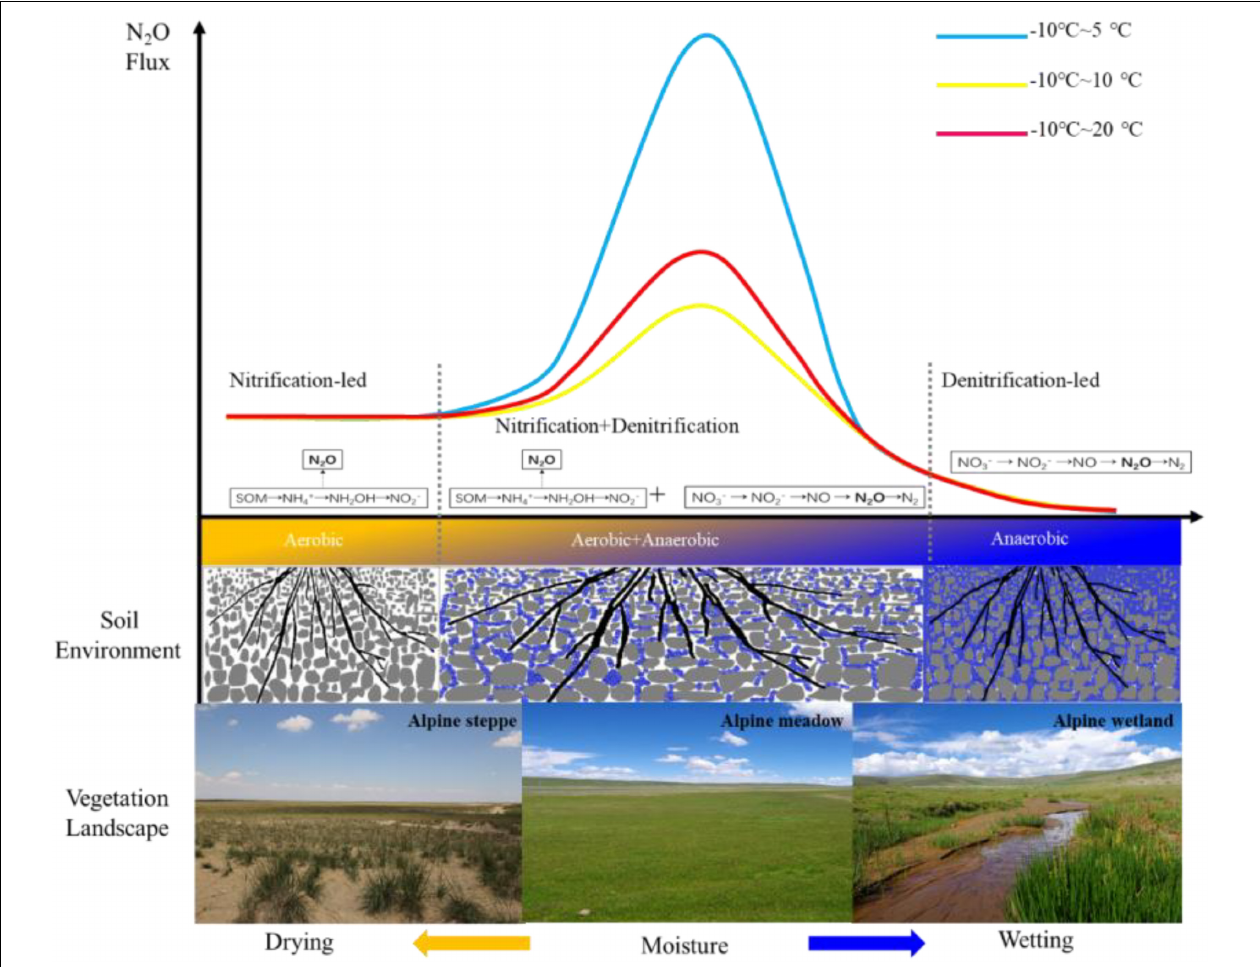
FIGURE 6 | Model of N 2 O flux response to soil moisture and temperature during short-term freeze–thaw cycles. The horizontal axis represents soil moisture, increasing from left to right. The diagram below the abscissa shows the soil environment under different soil water contents, in which the black lines represent plant roots, the gray irregular geometric shapes represent soil aggregates, the white gaps represent interstices of soil, and the blue parts represent soil free water. The photo of vegetation landscape from left to right is alpine steppe, alpine meadow, and alpine wetland. All the photos were taken by the first author in the Qinghai–Tibetan